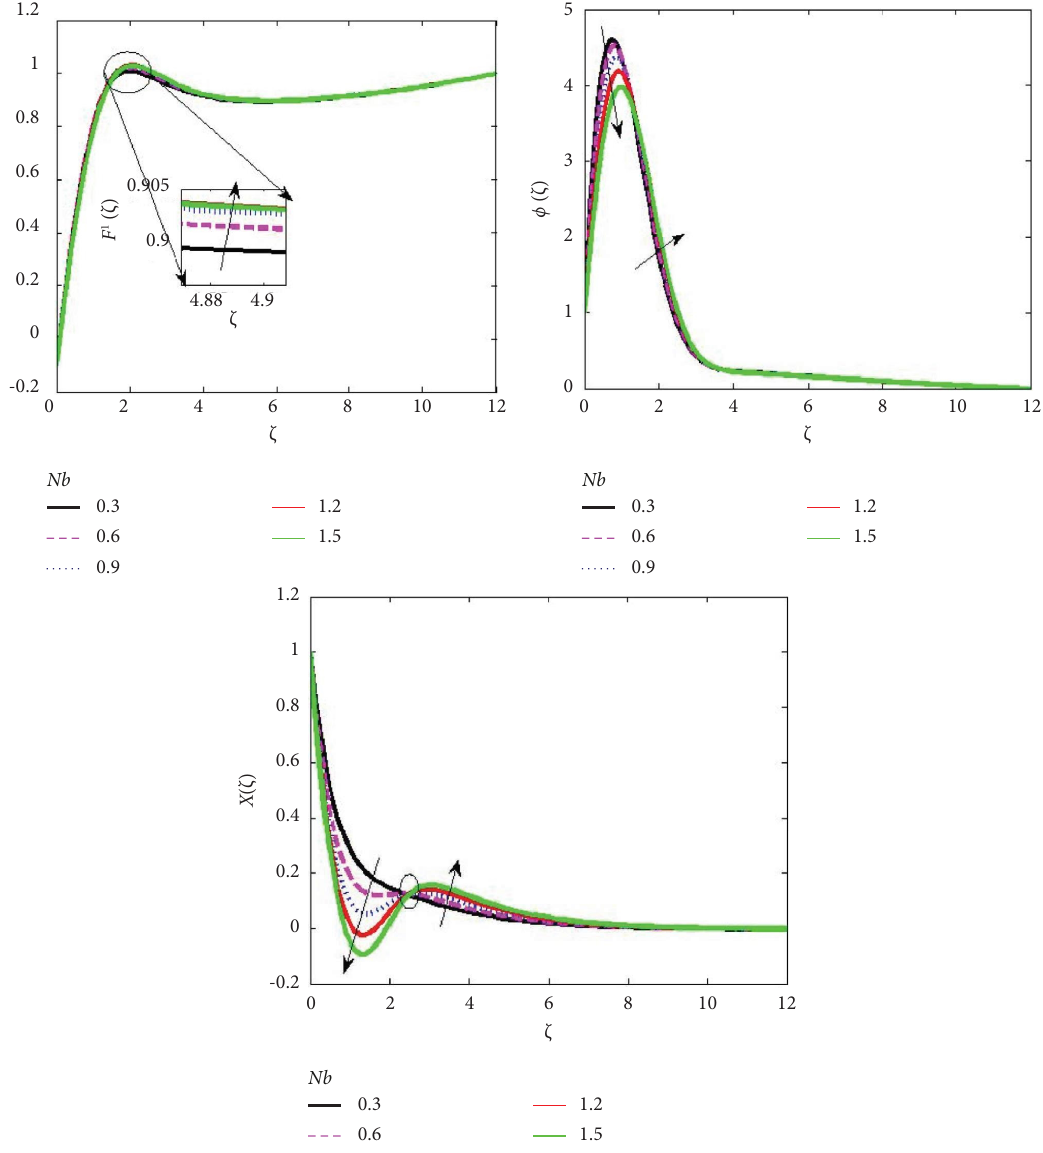
Figure 9: Efect of the Brownian motion parameter on the velocity, concentration, and motile density